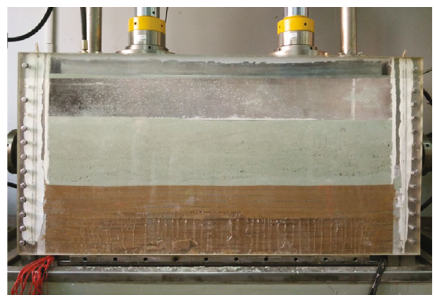
Figure 8: Physical model laying.